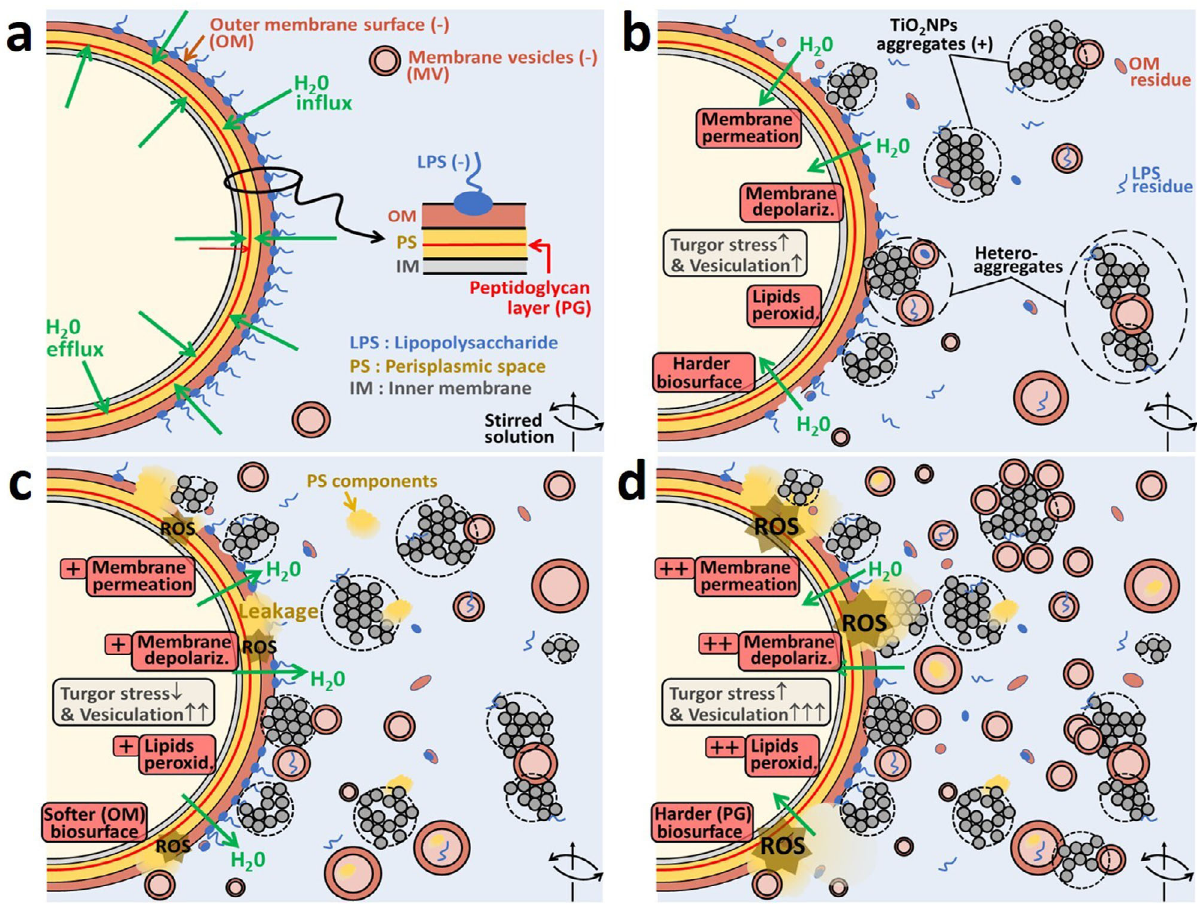
Fig. 10 Schematic representation of TiO 2 NP toxicity mechanisms towards the most TiO 2 NP-sensitive JW3606 (hep + ) mutant with un-truncated inner core LPS. Schematic overview (not to scale) of the modes of action of TiO 2 NPs on JW3606 (hep + ). a Cells unexposed to TiO 2 NPs, and osmoregulation (water fl ux balance in the periplasm). b Regime I. c Regime II. d Regime III. Nomenclature: OM outer membrane, IM inner membrane, PS periplamic space, PG peptidoglycan layer, MV membrane vesicle, ROS reactive oxygen species. Green arrows indicate the water fl ux direction. ( − ) and ( + ) denote the sign of the charge carried by the OM surface, MVs and TiO 2 NPs. From ( a ) to ( d ), the TiO 2 NP concentration in the exposome gradually increases from 0 to 50